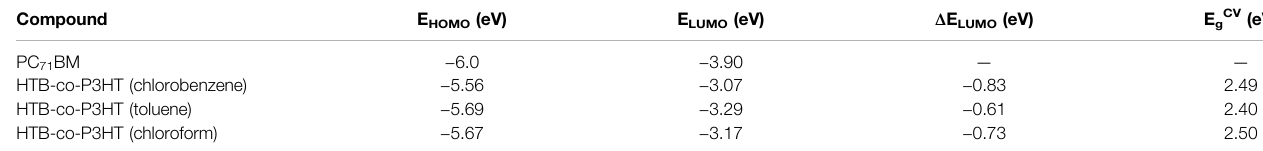
TABLE 2 | Electrochemical properties of HTB-co-P3HT in different solvents. Compound